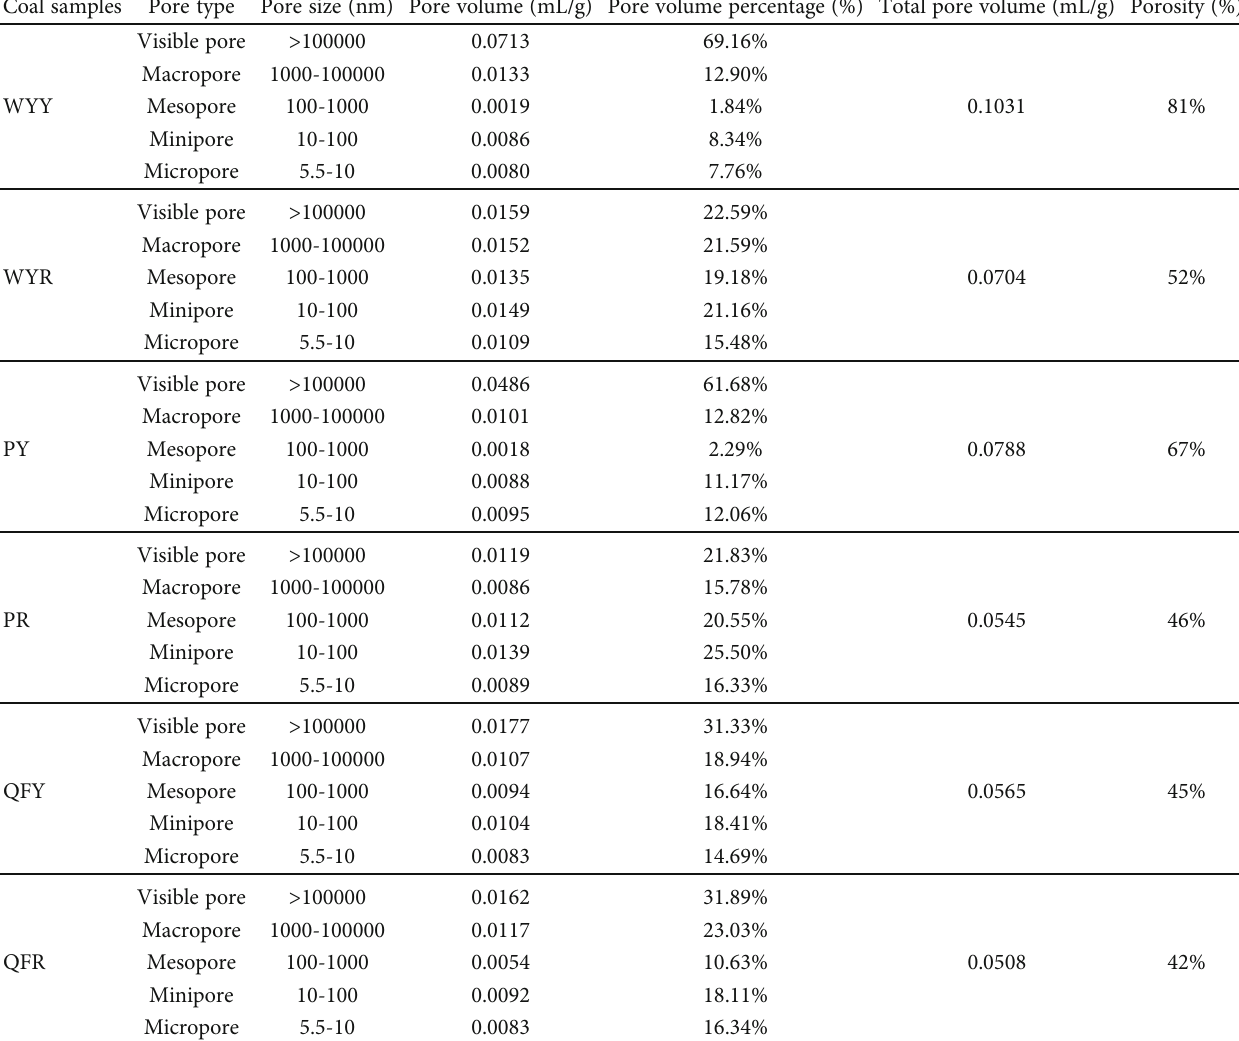
Table 3: Pore size parameters of coal